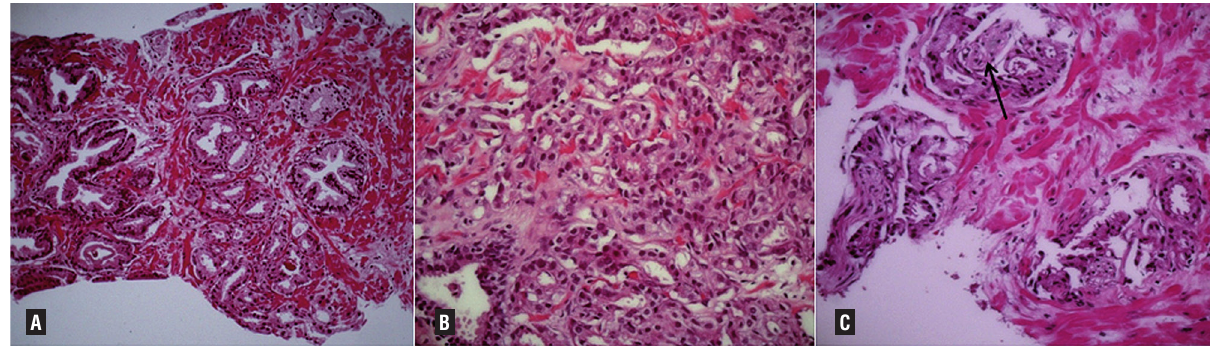
Figure 1 - Examples of biopsies that resulted in change in the final diagnosis. A) A case of atypical adenomatous hyperplasia or adenosis previously diagnosed as adenocarcinoma. B) Gleason pattern 4 in a case previously diagnosed as Gleason score 6 (3+3). C) Perineural invasion (arrow) that had not been recorded in the original